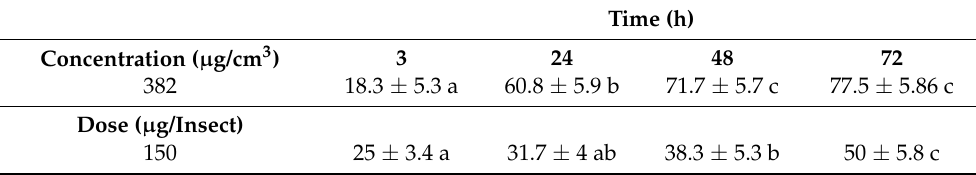
Figure 3. Larvicidal activity (%) of L. botrana to PLF He and its fractions (PLF He at 25 mg/mL and percentage of contribution of each fraction to the PLF He , pie graph) recorded at 3, 24, 48, and 72 h after Petri dish residual exposure bioassay. Means followed by the same letter within each column (fraction/h) are not significantly different (Duncan’s multiple range tests [MRT] test p > 0.005). Table 5. Larvicidal activity (%) of PLF He2 to L. botrana recorded at 3, 24, 48, and 72 h after Petri dish residual exposure bioassay at 25 mg/mL (first row) and topical bioassay at 75 μ g dose (second row). Means followed by the same letter within each row are not significantly different (Duncan’s multiple range tests [MRT] test p > 0.005).